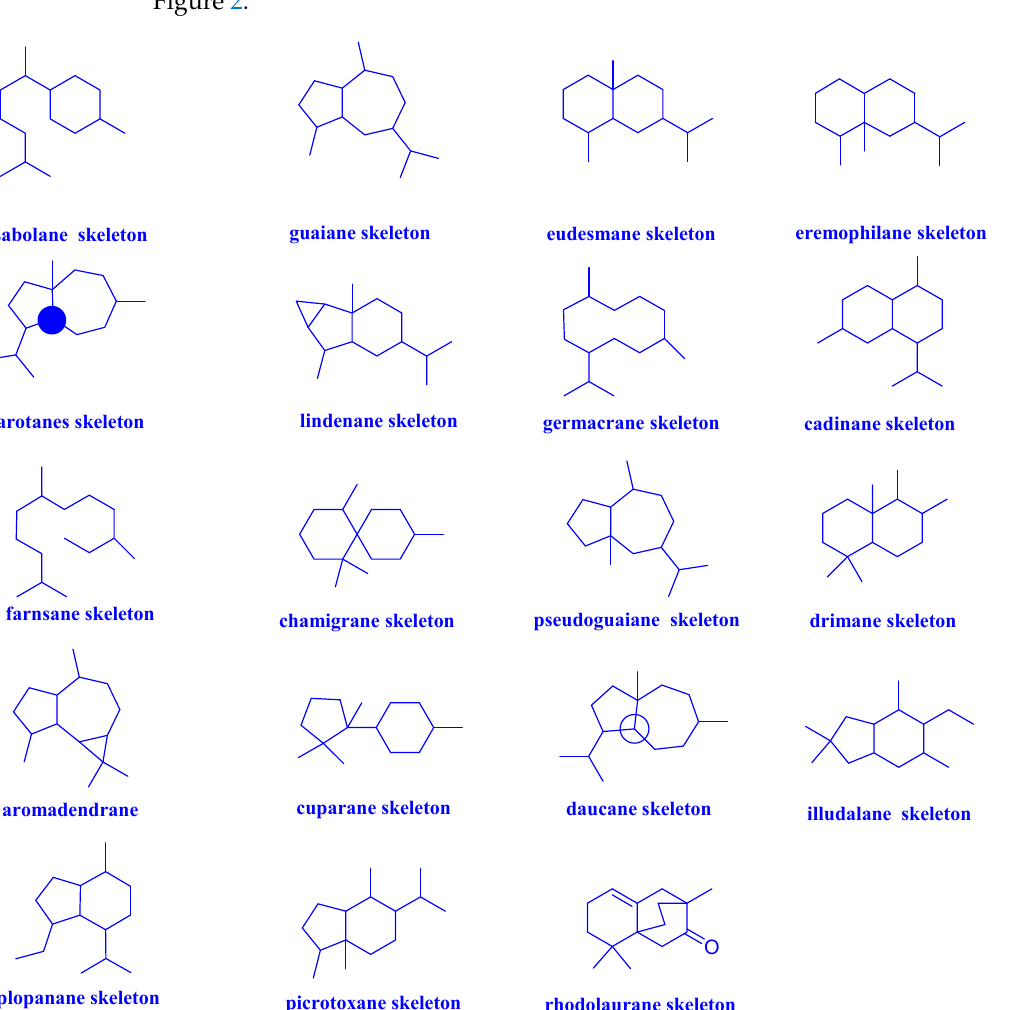
Figure 2. Groups in shorthand. 2.1. Bisabolanes Laurecomposin A, laurecomposin B, preintricatol, helianthol B, and gossonorol ( 1 – 5 , Figure 3) were isolated from the red alga Laurencia tristicha. The complete 1H and 13C NMR assignments of compound 1 were made by a combination of 1H, 13C, DEPT, 1He1H COSY, HSQC, HMBC, and ROESY experiments and the absolute configuration was estab- lished by the modified Mosher’s method. It was confirmed that compound 1 had activity against Staphylococcus aureus ( S. aureus ) and Candida albicans ( C. albicans ) SC5314 with MIC values of 26.8 and 16 µg/mL, respectively. Compound 1 also had an obvious inhibitory effect on Microsporum gypseum ( M. gypseum ), and the MIC value was 4.0 µg/mL. In the antifungal and antibacterial assays, compound 2 exhibited significant inhibitory activities